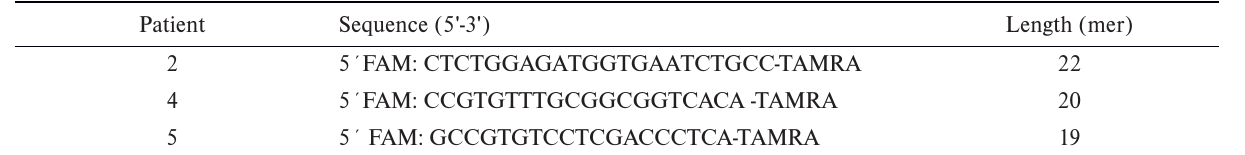
Table S3. Sequences of designed probes for RQ-PCR detection of tumor-specific marker in